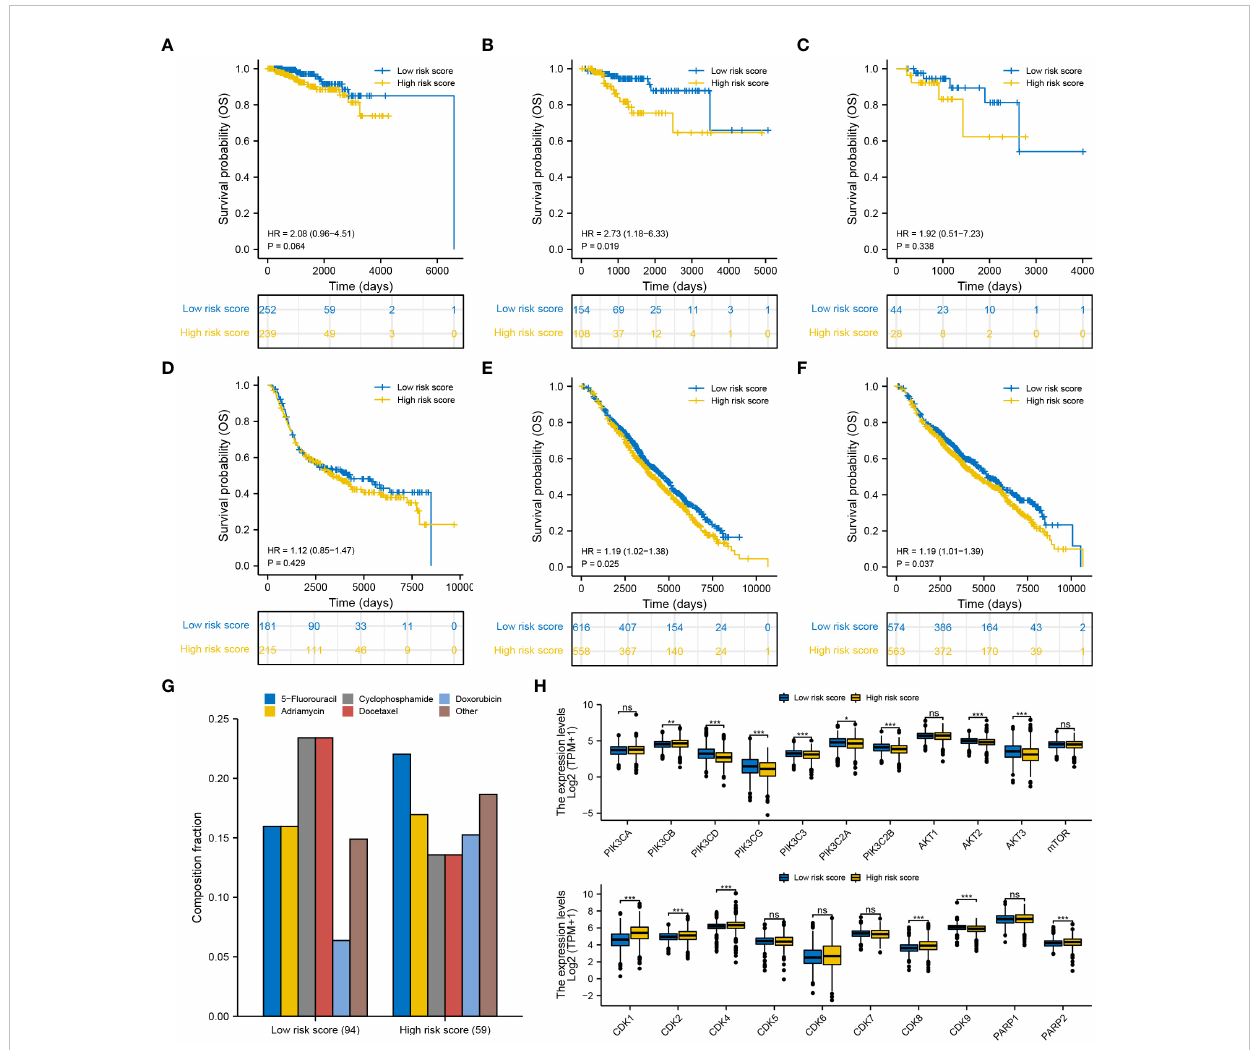
FIGURE 11 Ef fi ciency of the degradome signature in predicting the prognosis of patients with BRCA undergoing different therapies. Differences in the survival of patients undergoing (A) chemotherapy, (B) endocrinotherapy and (C) radiotherapy between the low- and high-risk groups in TCGA cohort. Differences in the survival of patients undergoing (D) chemotherapy, (E) endocrinotherapy and (F) radiotherapy between the low- and high-risk groups in the METABRIC cohort. (G) Proportion of patients with complete response to the fi rst-round chemotherapy and the corresponding drug agents in the two risk groups. (H) Expression pattern of 21 potential molecular targets between the low- and high-risk